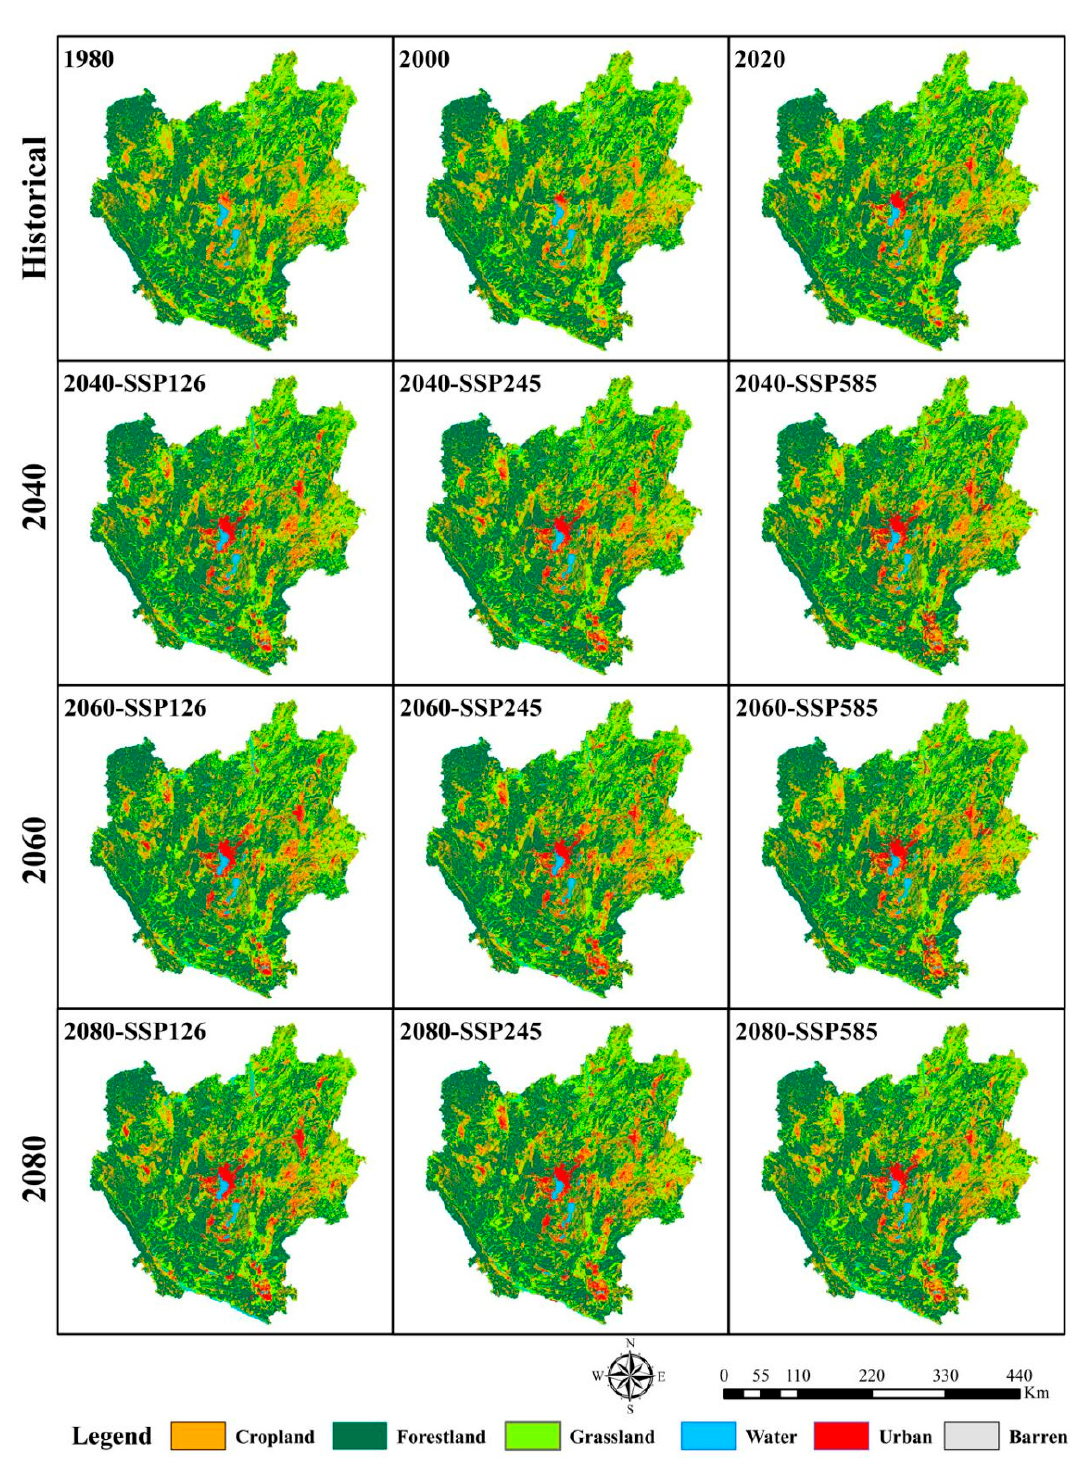
Figure 5. Spatio-temporal evolution of land use.